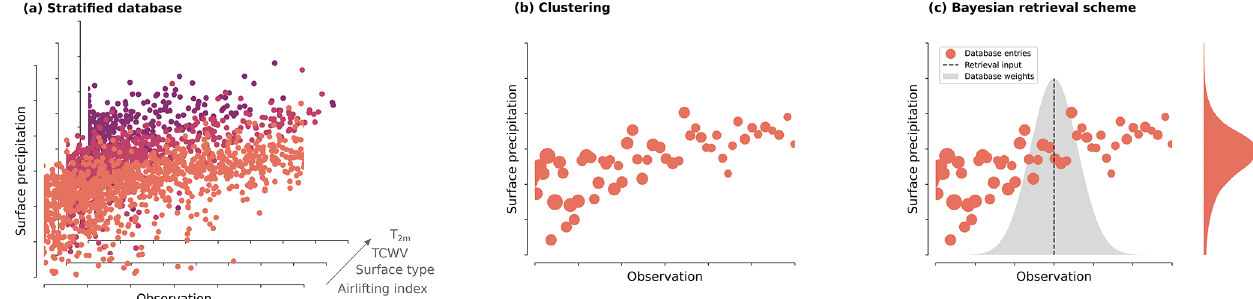
Figure A1. Components of the GPROF retrieval algorithm. Panel (a) illustrates the binning of the database with respect to the ancillary data, which consists of 2m temperature ( T 2m ), total column water vapor (TCWV), surface type, and the airlifting index. Panel (b) illustrates the clustering of each database bin into self-similar clusters, with the size of the markers representing the number of profiles in each cluster. Panel (c) illustrates the Bayesian scheme that is used to approximate the posterior distribution of the retrieval, which corresponds to the filled curve to the right, by weighting the samples in the database.